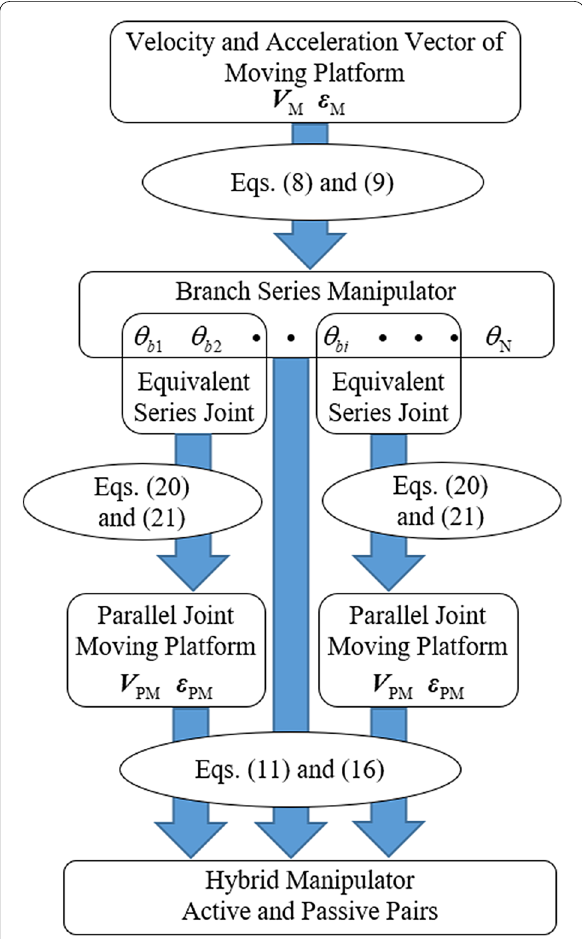
Figure 4 First method for the inverse kinematics analysis of hybrid mechanisms